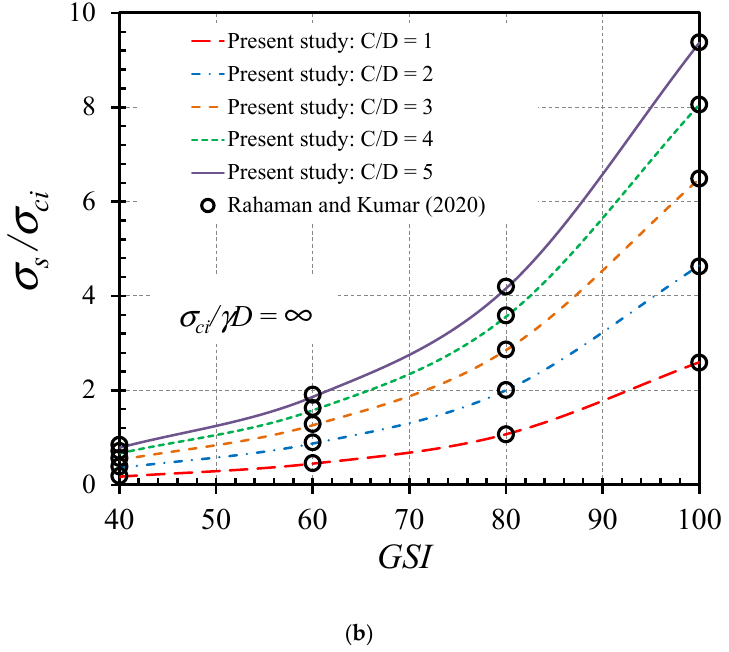
Figure 3. Verification of the stability factor σ s / σ ci of horseshoe tunnels with B / D = 1 and m i = 5 between the current study to those available solutions: ( a ) σ ci / γ D = 100 and ( b ) σ ci / γ D = ∞ .